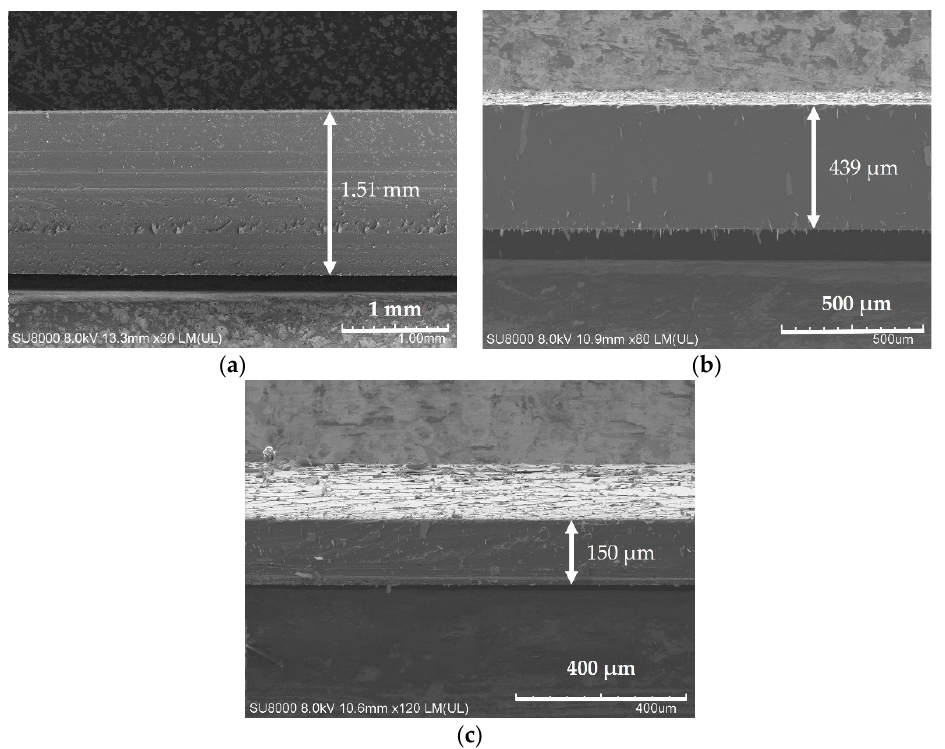
Figure 2. Scanning electron microscope (SEM) micrographs of the cross-sectional morphology of the PDMS substrates prepared with the three different spinning speeds. ( a ): The cross-sectional of PDMS thickness with 1.51 mm at the rotation speed of 0 r/min; ( b ): The cross-sectional of PDMS thickness with 439 µ m at the rotation speed of 500 r/min; ( c ): The cross-sectional of PDMS thickness with 150 µ m at the rotation speed of 1000